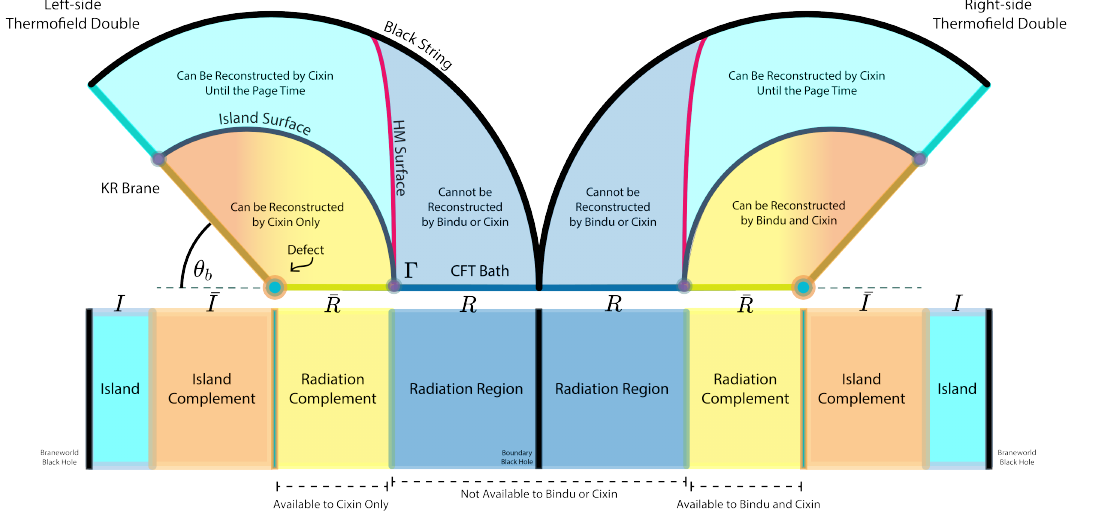
¯ R only if both sides and decreases b